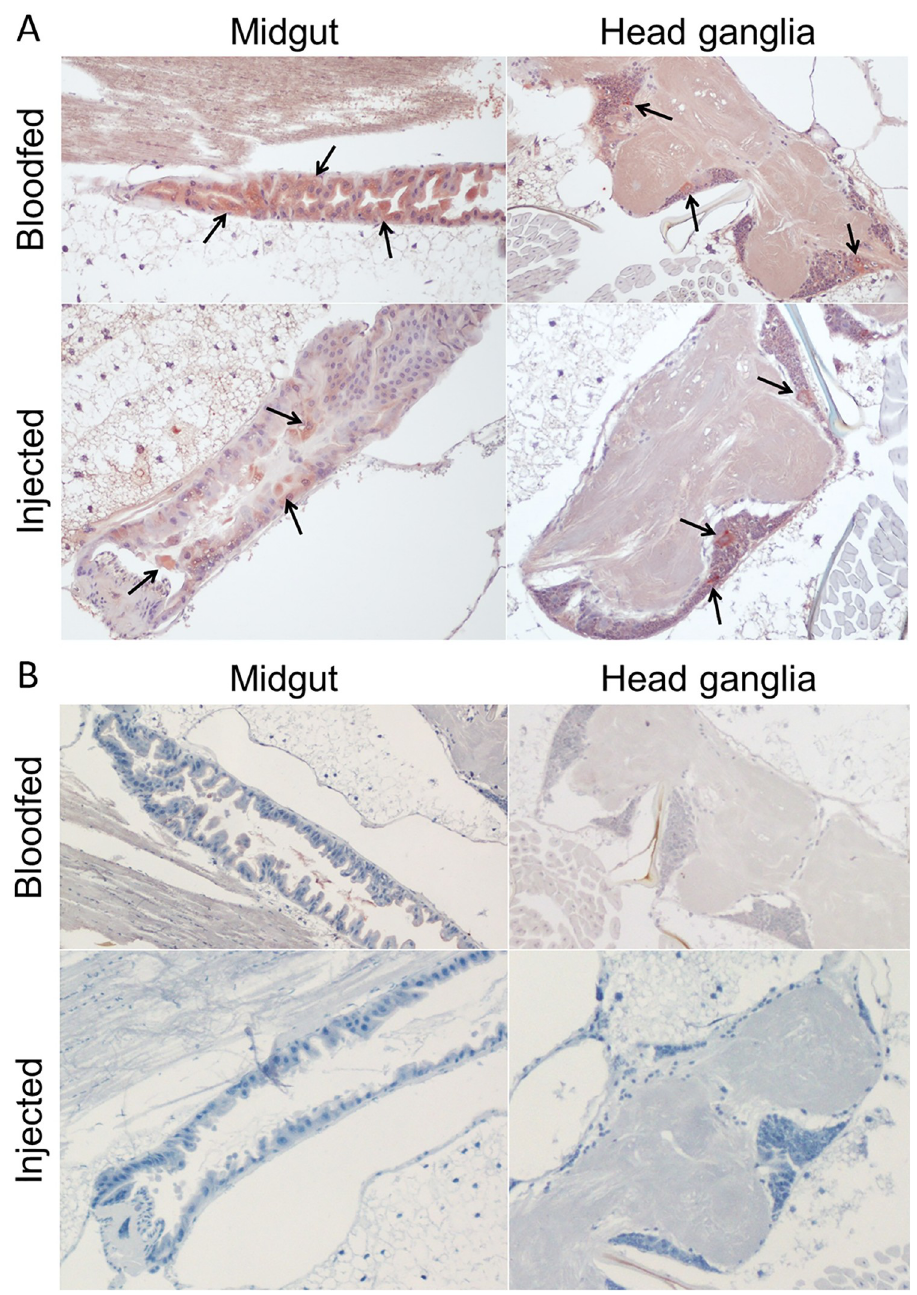
Fig 2. Detection of BgV in blood-fed and injected Cx . annulirostris infected with BgV using IHC. The mosquito sections were immunolabeled using a cocktail of BgV-reactive mAbs which enabled identification of (A) positive mosquitoes showing presence of BgV antigen in red (arrows) in the midgut epithelial cells and the neuronal cells in the head ganglia, and negative mosquitoes (B) with no specific signal.